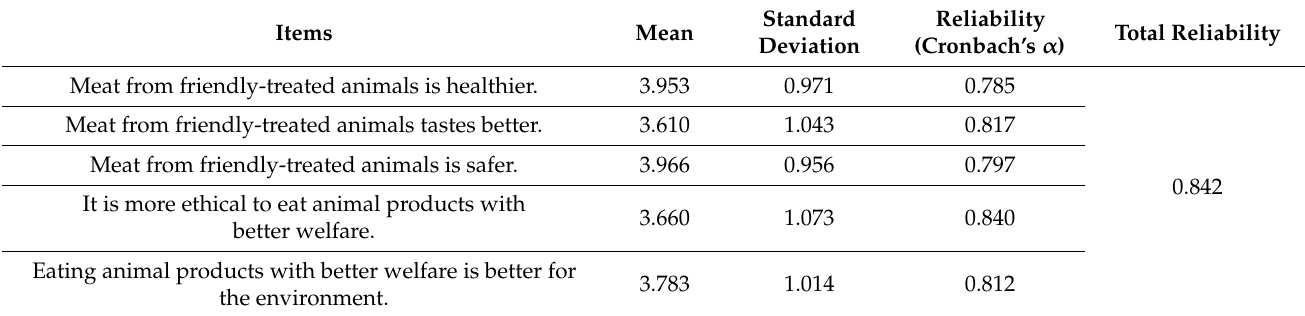
Table 4. Cognition of farm animal welfare